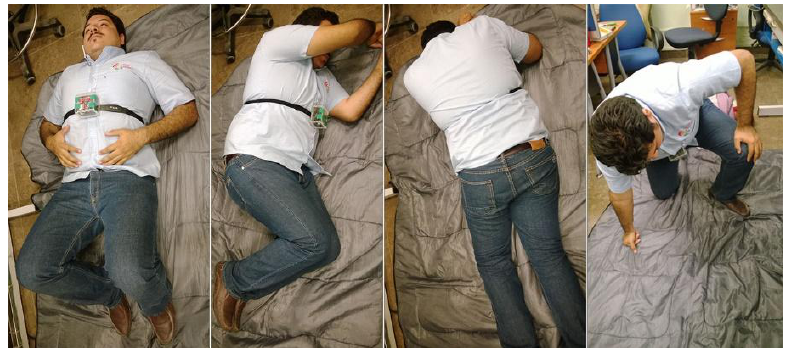
Figure 7. Fall tests.